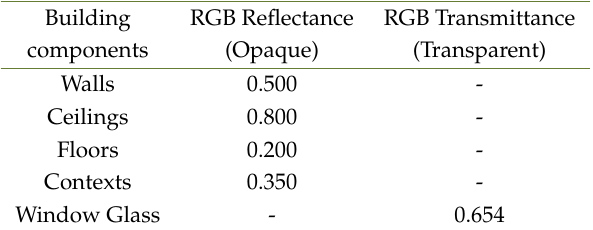
Table 2. Radiance RGB material